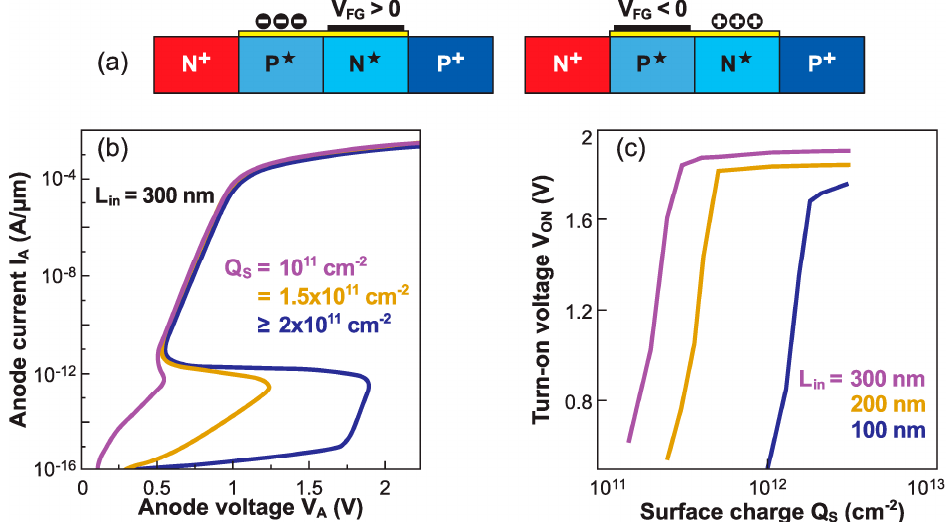
Figure 22. ( a ) Configuration of the Z 2 –FET operated as a biosensor for detection of negative and positive surface charges. ( b ) Output characteristics and ( c ) turn-on voltage vs. negative surface charge in devices with variable ungated region lengths.